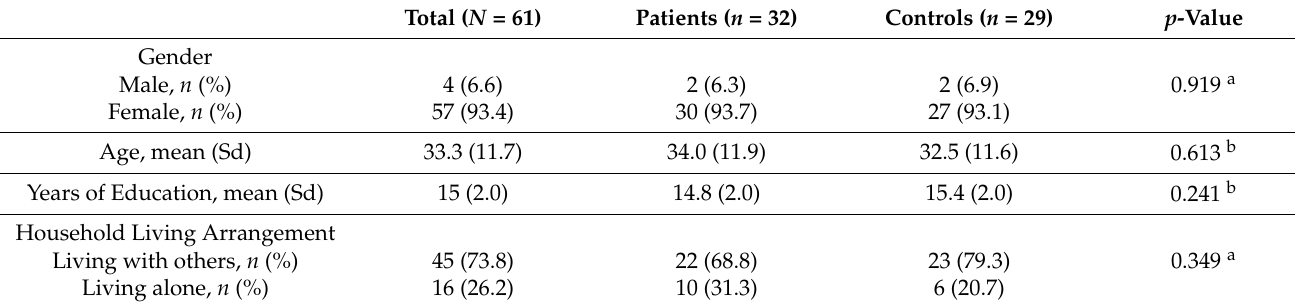
Table 1. Demographic data of participants (total and per